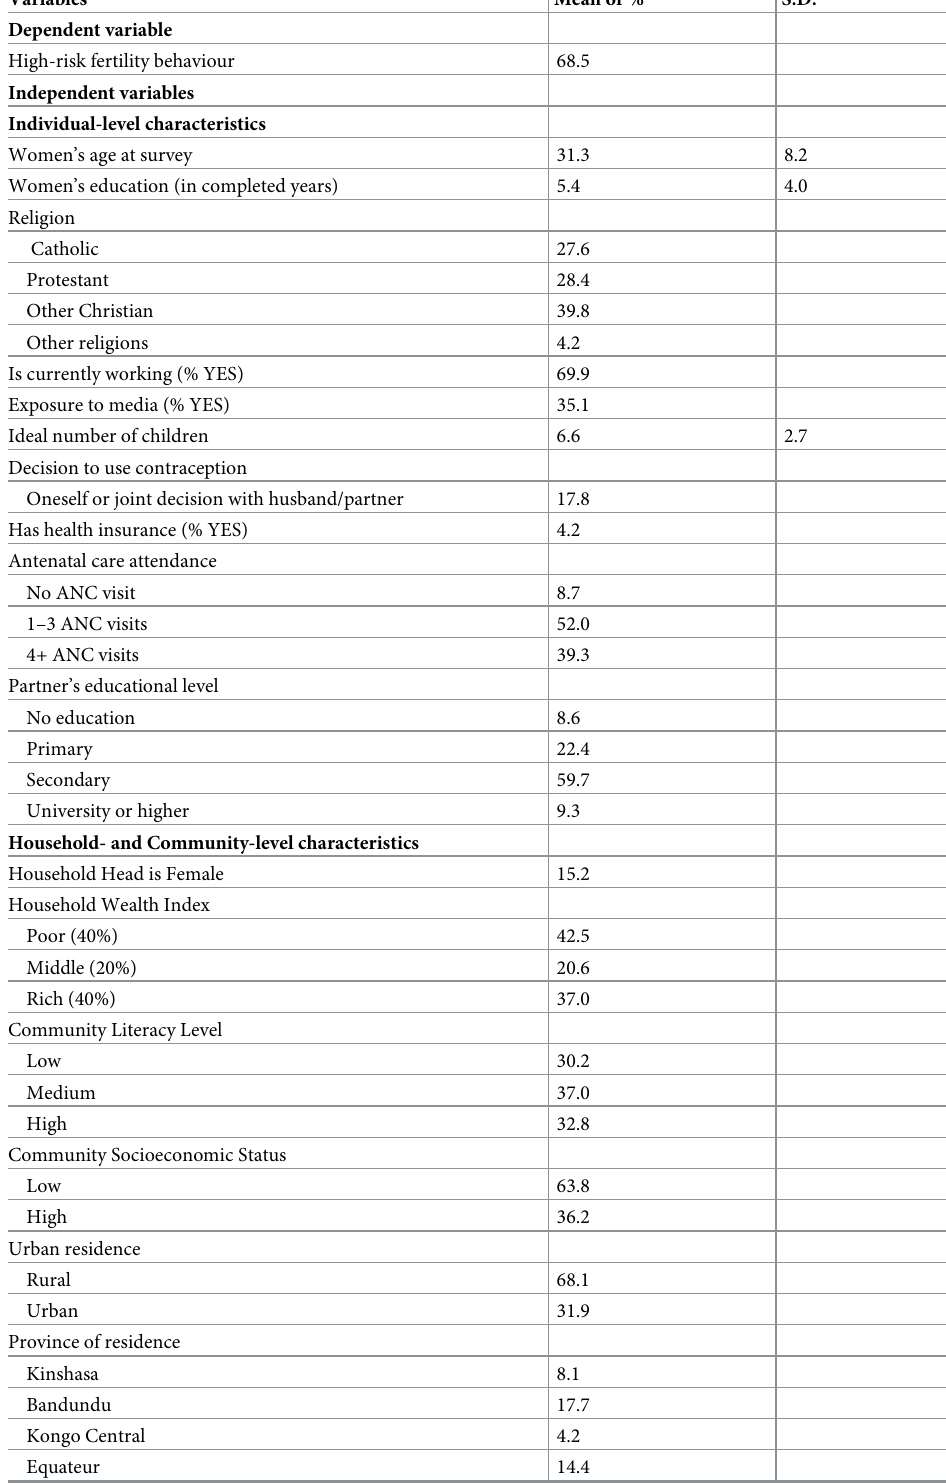
Table 1. Descriptive statistics of married women in the Democratic Republic of the